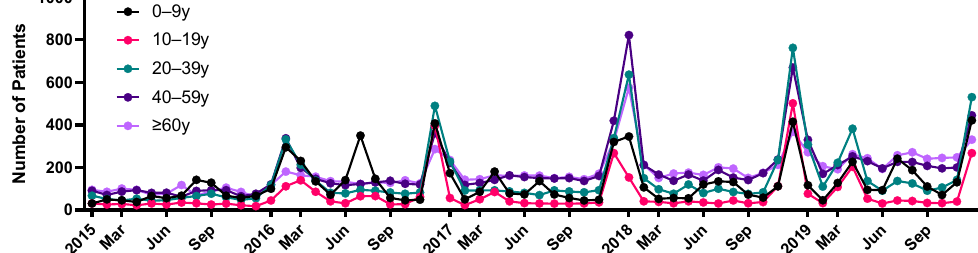
Figure 2. Monthly trend analysis of encephalitis according to age.